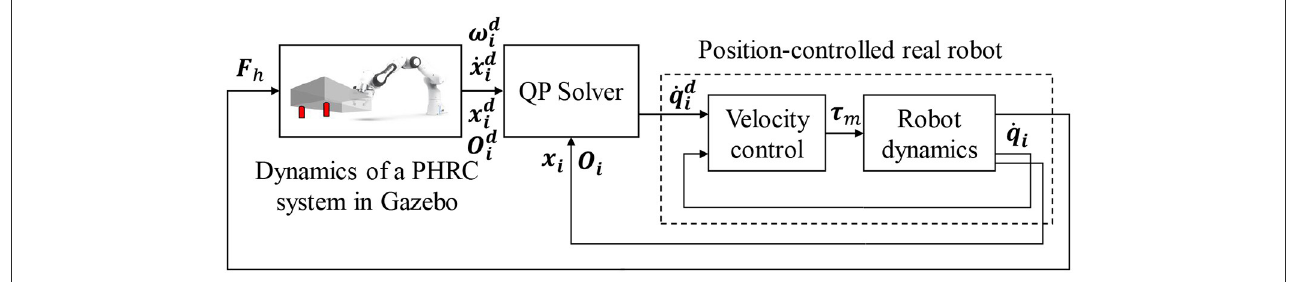
FIGURE3 Implementation of the haptic rendering module based on an admittance-type control scheme.